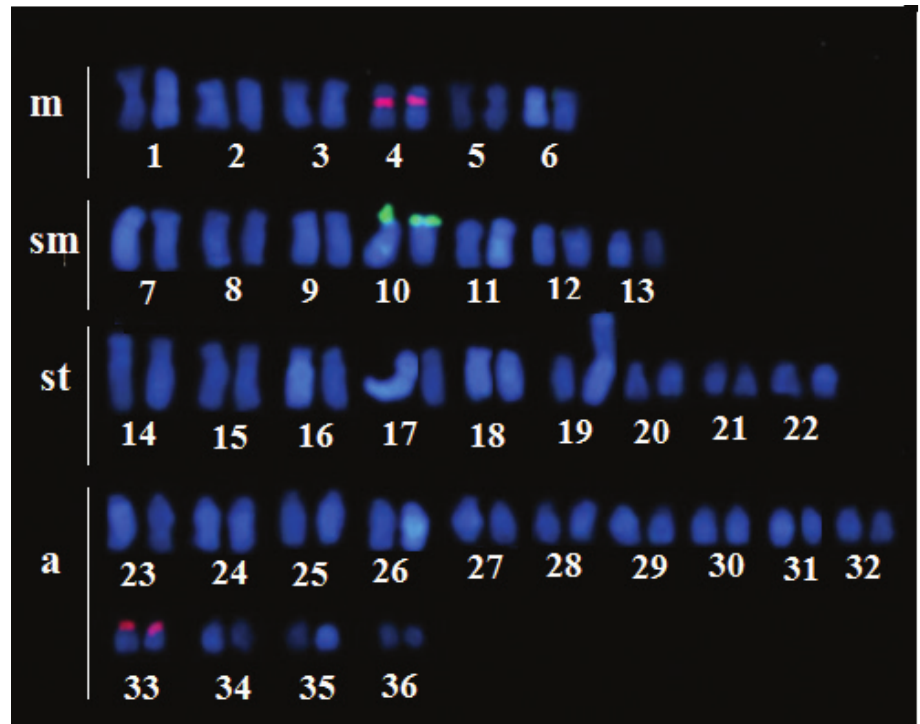
Figure 4. Karyotype of karyomorph B of Hypostomus regani after FISH with rDNA probes. Green: 18SrDNA probe; red: 5S rDNA probe. Scale bar: